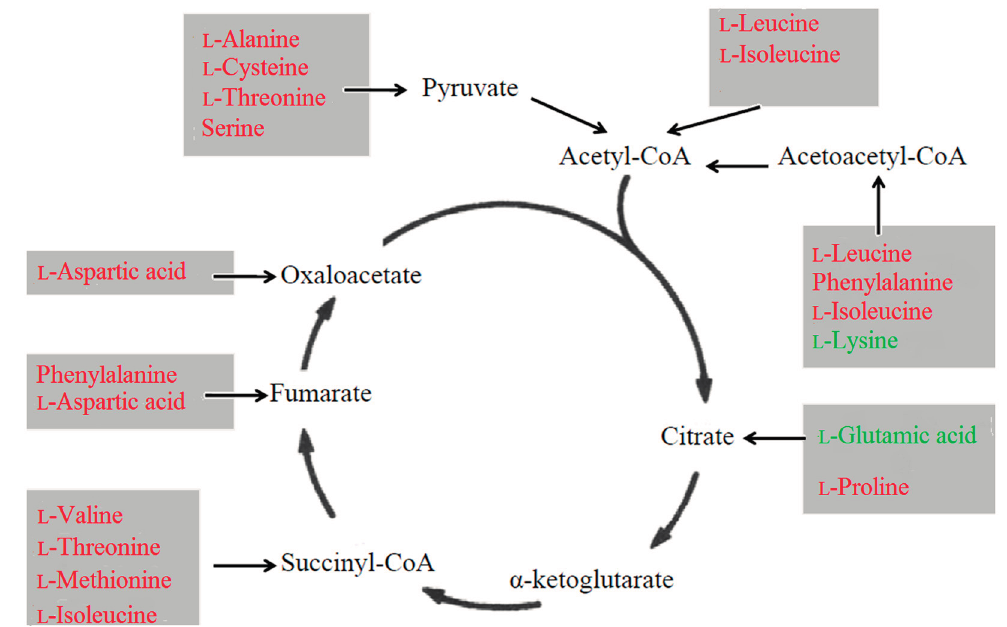
Figure 4. Relationship between perturbed amino acids and energy pathways. Red font indicates decreases in both the Hu-H1 and Strain V groups. Green font indicates decreases in the Strain V group